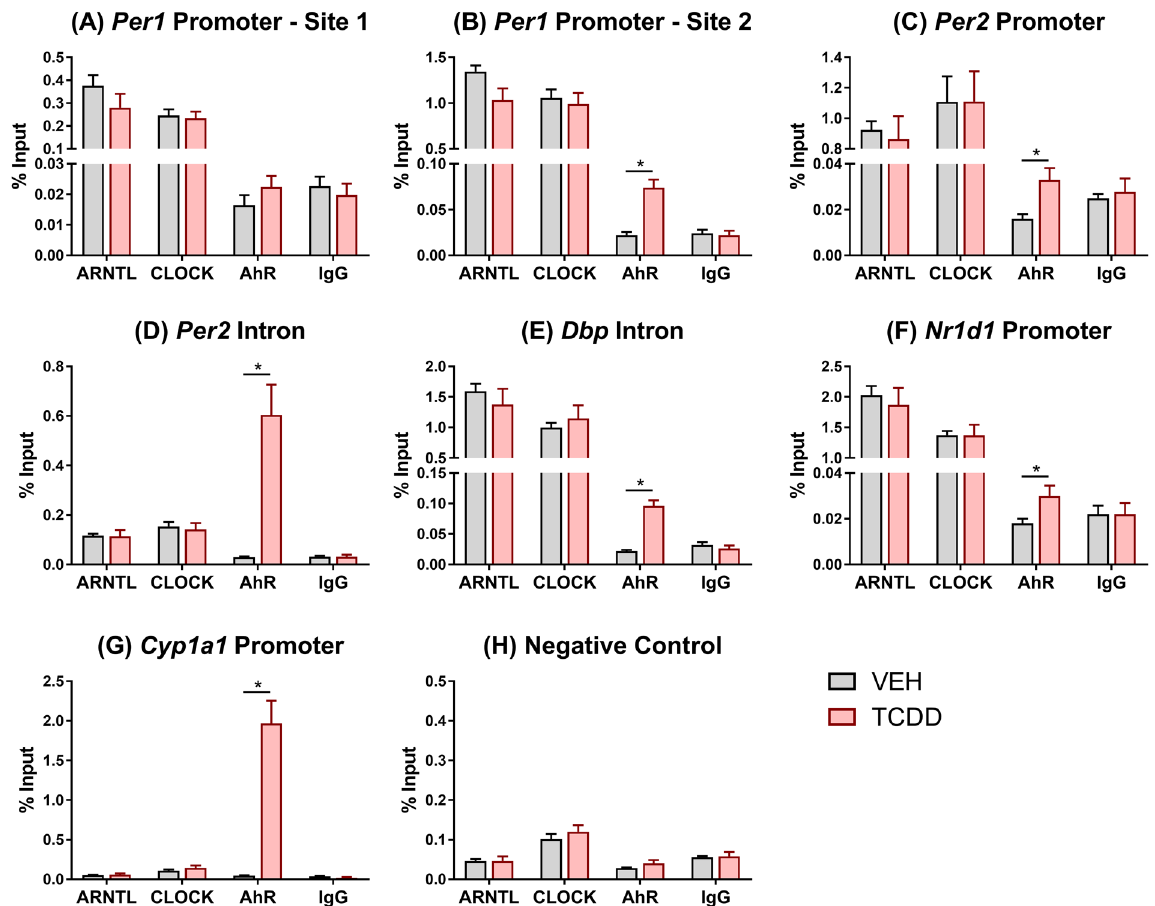
Figure 7. Comparison of ARNTL, CLOCK, and AhR genomic enrichment within target genes assessed using chromatin immunoprecipitation (ChIP). Liver samples were collected at ZT4–6 from male C57BL/6 mice 2 h following a single bolus dose of sesame oil vehicle or 30 µ g/kg TCDD. Genomic enrichment was quantified by qRT-PCR using primers targeting regions within ( A , B ) Per1 , ( C , D ) Per2 , ( E ) Dbp , and ( F ) Nr1d1 as described in Supplementary Table S2. ( G ) Cyp1a1 was used as a positive control for AhR binding, while ( H ) a negative control region on chromosome 6 was used to confirm the specificity of each immunoprecipitation. Data points represent the average % input of 4–5 individual mice ± standard error of the mean. Statistical significance ( * p ≤ 0.05) between vehicle- and TCDD-treated mice was determined using a